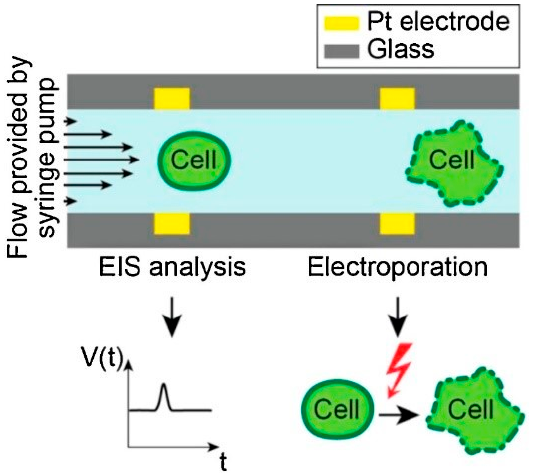
Figure 12. Design and working principle of the microchip. Reprinted with permission from ref. [111]. Copyright © 2015